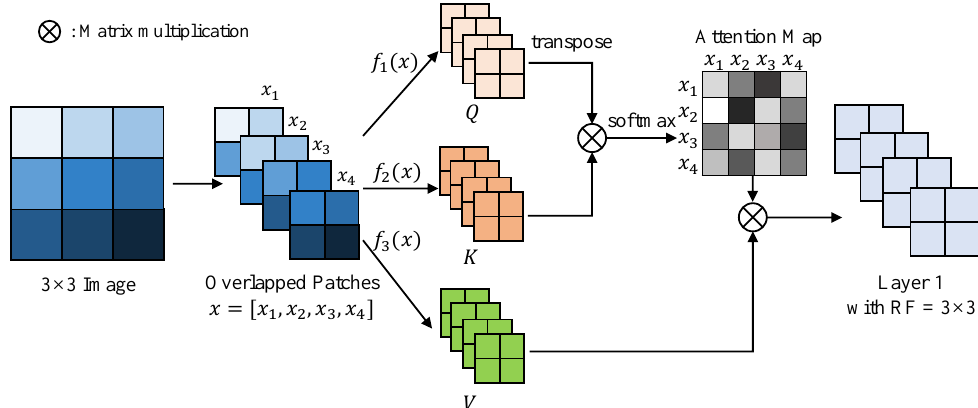
Figure 3. A simplified illustration of the self-attention mechanism in vision Transformer. The self- attention mechanism takes the overlapped patches of an image as input. These patches are encoded in three ways, i.e., f 1 , f 2 , f 3 , to get three matrices Q , K , V , short for Query, Key, and Value, respectively. The softmax result of the matrix product of Q and K is called the attention map, which represents the similarity or weights between each pair of patches. The darker the color in the attention map, the stronger the relationship between the two patches. The attention map is multiplied with the matrix V to get the feature layer 1, which is the output of the self-attention module. Unlike the convolution, self-attention module has a receptive field of the entire